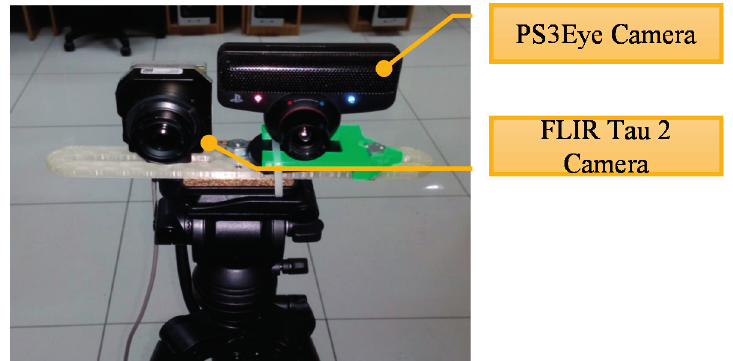
Figure 3. Physical setup of the PUCV- VisibleThermal-Face (VTF) database acquisition system.